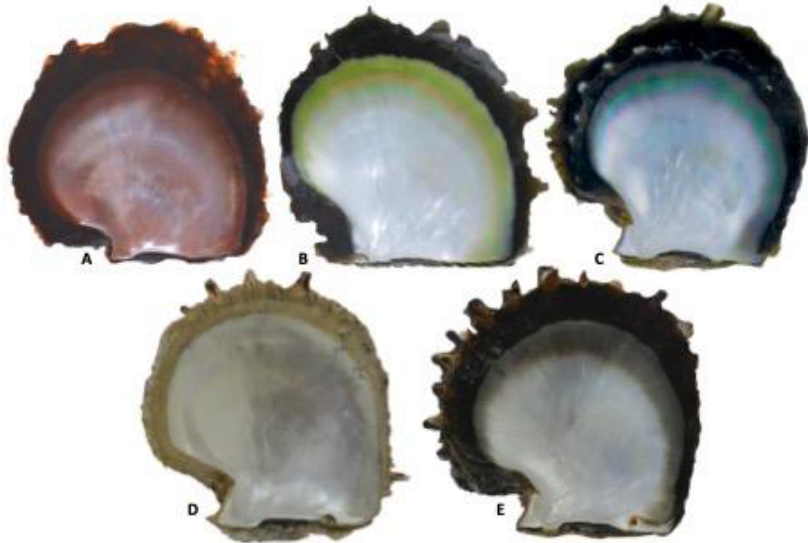
Figure 1. Different colors of P. margaritifera inner shell: ( A ): red, ( B ): yellow, ( C ): green, ( D ): albino, ( E ): black.